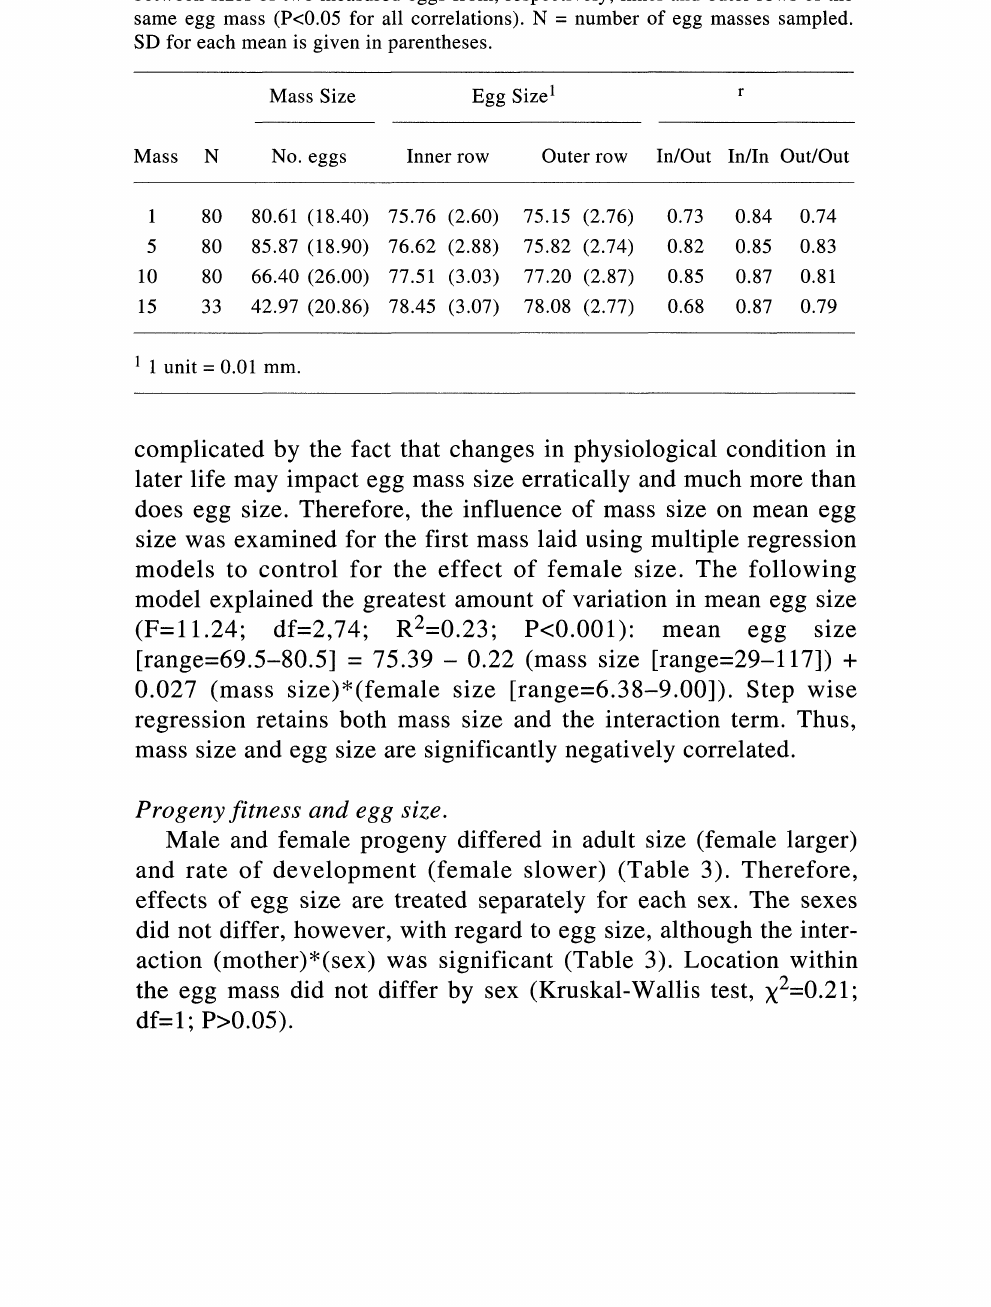
Table 2. Relationships between egg mass number (in the sequence laid) and mass size (number of eggs), egg size, and intra-mass correlation (r) in egg size. In inner egg row, Out outer egg row. In/Out correlation between mean size of inner and outer row eggs within the same egg mass. In/In and Out/Out correlation between sizes of two measured eggs from, respectively, inner and outer rows of the same egg mass (P<0.05 for all correlations). N number of egg masses sampled. SD for each mean is given in